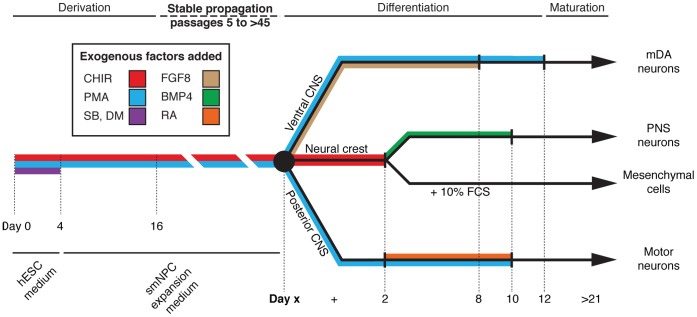
Summary of smNPCs.Diagram illustrating the conditions used to derive, propagate, and differentiate smNPCs. CHIR = 99021, DM = dorsomorphin, FCS = fetal calf serum, PMA = purmorphamine, RA = all-trans retinoic acid, and SB = SB43152.